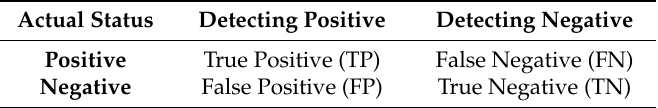
Table 4. Definition on confusion